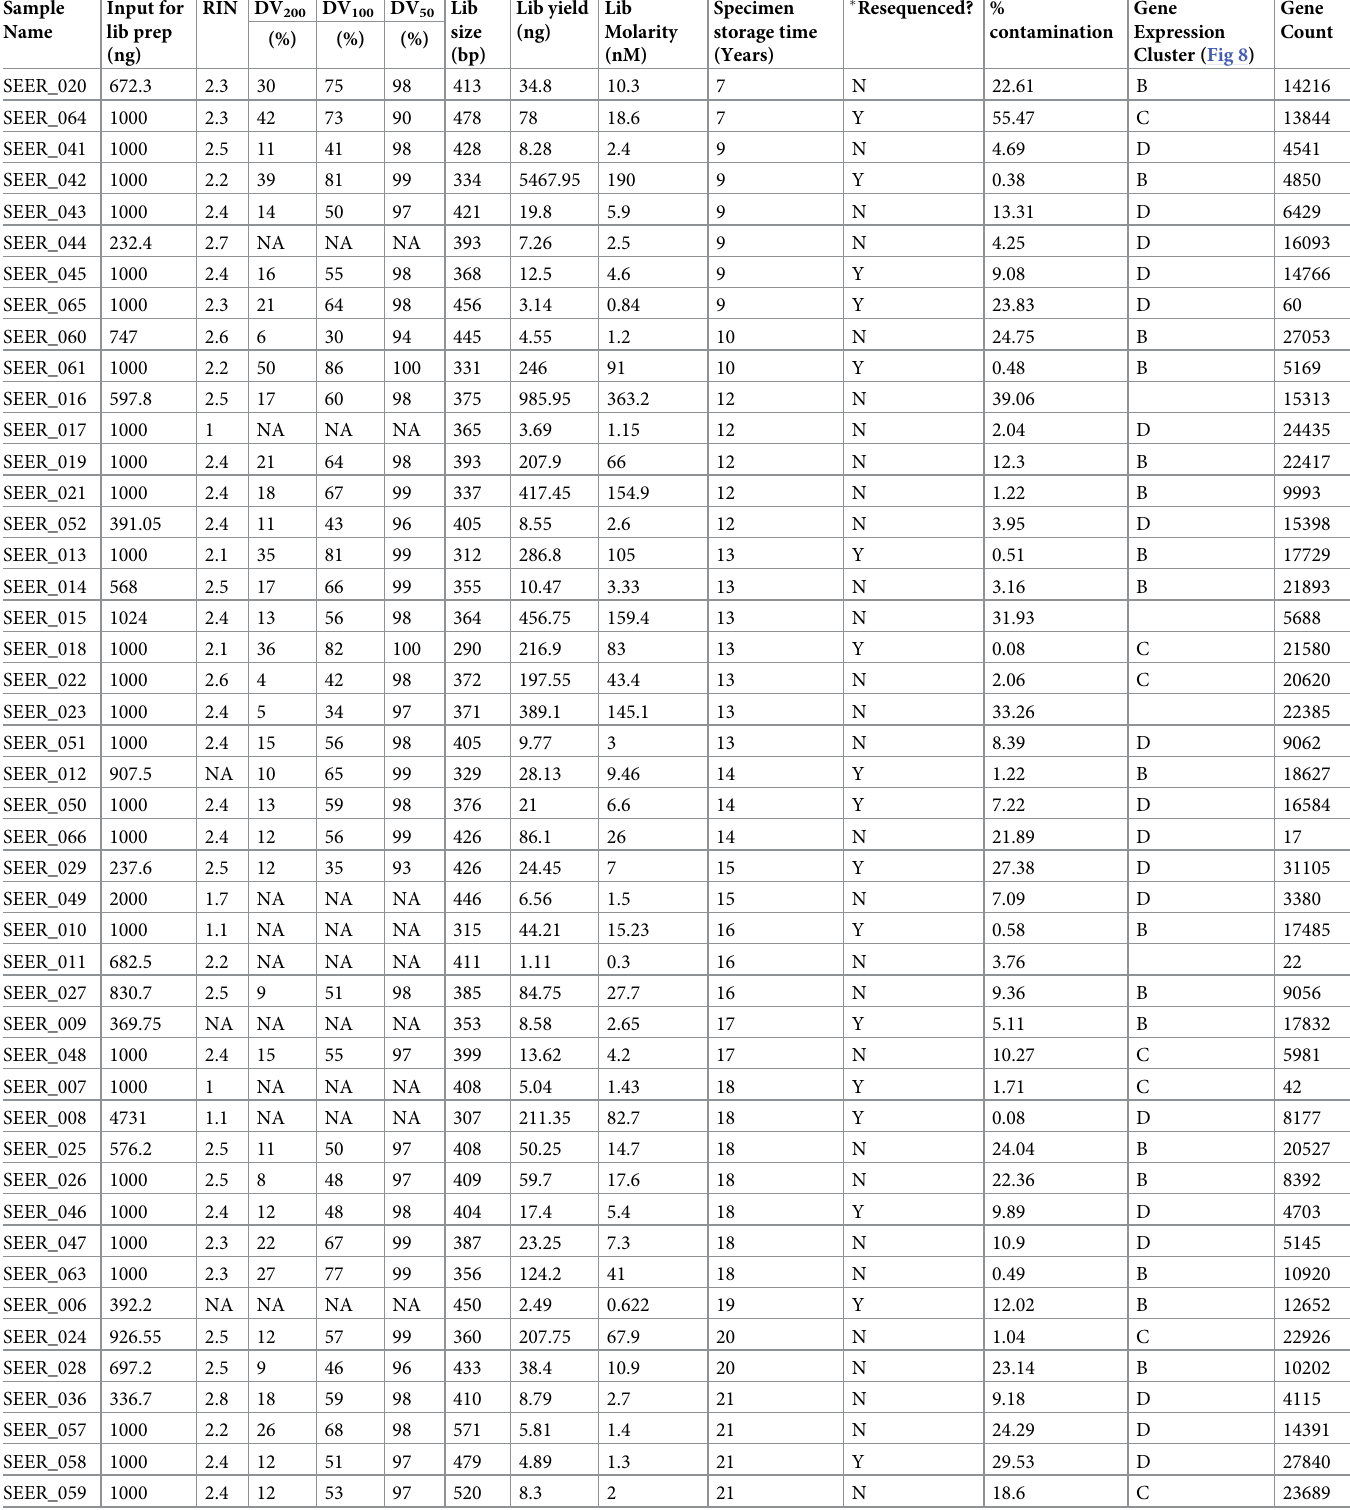
Table 2. All Samples QC Results (sorted by specimen storage